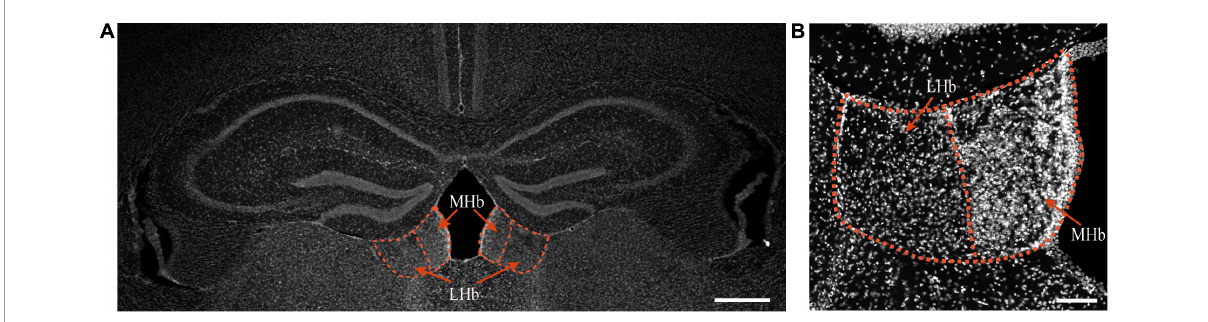
FIGURE1 The habenula in mice in physiological state. Top, the location of the MHb and LHb is indicated by red circles and red arrows, bar = 500 µ m (A) . DAPI staining of the habenula of mice, bar = 100 µ m (B) .